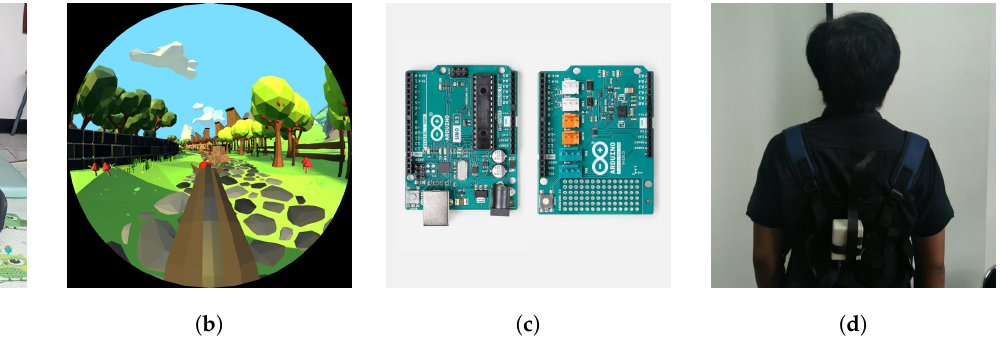
Figure 4. HRS and exergaming equipment: ( a ) Jufit JFF043QM Horse Riding Simulator (HRS) device, ( b ) Sirkus Apel game screenshot, ( c ) Arduino UNO R9 and 9-axes motion shield, ( d ) Packaged inertial sensor controller worn by a user.